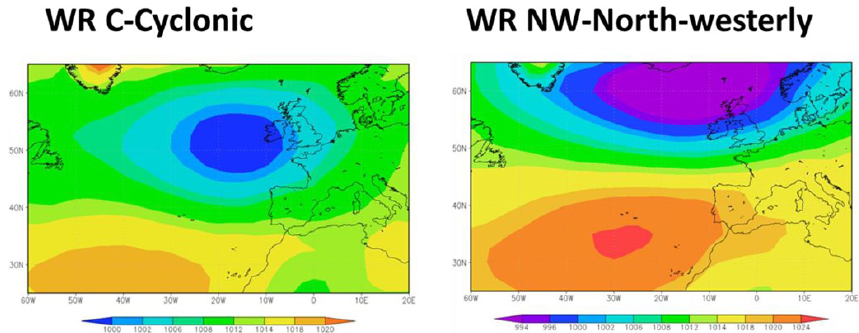
Fig. 2. Sea level pressure (SLP; hPa) depicting the weather regimes (WR) for the regime cyclonic (left panel) and north-westerly (right panel) averaged for the time period 1948–2011. Adapted from Santos et al. (2005).